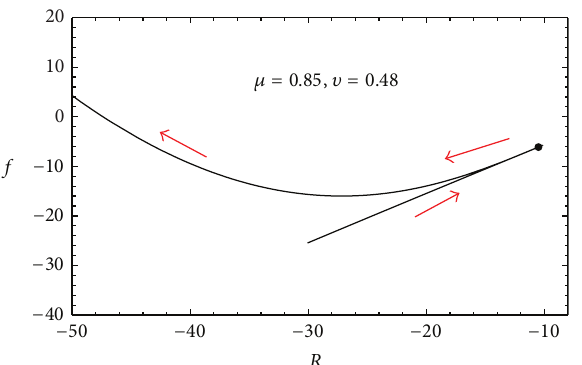
Figure 14: Future evolution of 𝑓(𝑅) for (𝜇,𝜐) = (1, 0.63) with −1 ≲ 𝑧 ⩽ 2 . The dot denotes the present day and is the point of reversion for DE dominated model.